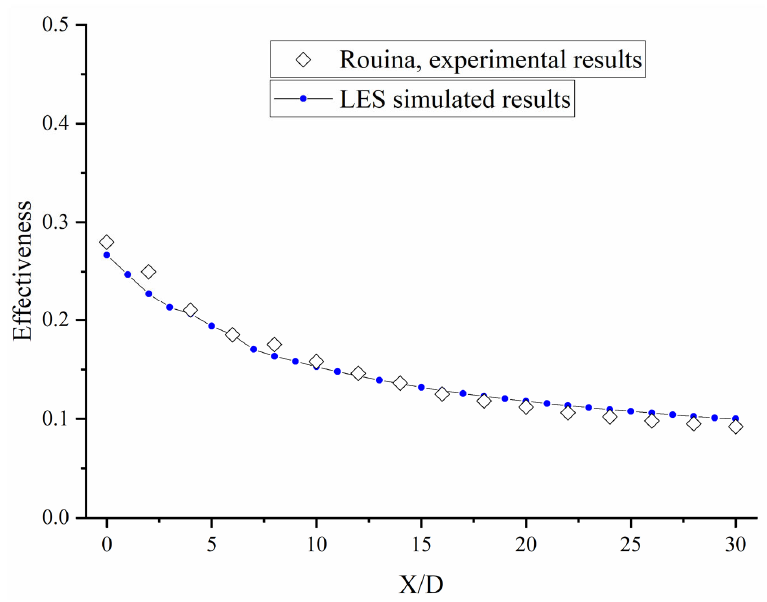
Figure 5. Comparison of LES and experimental results [32] .